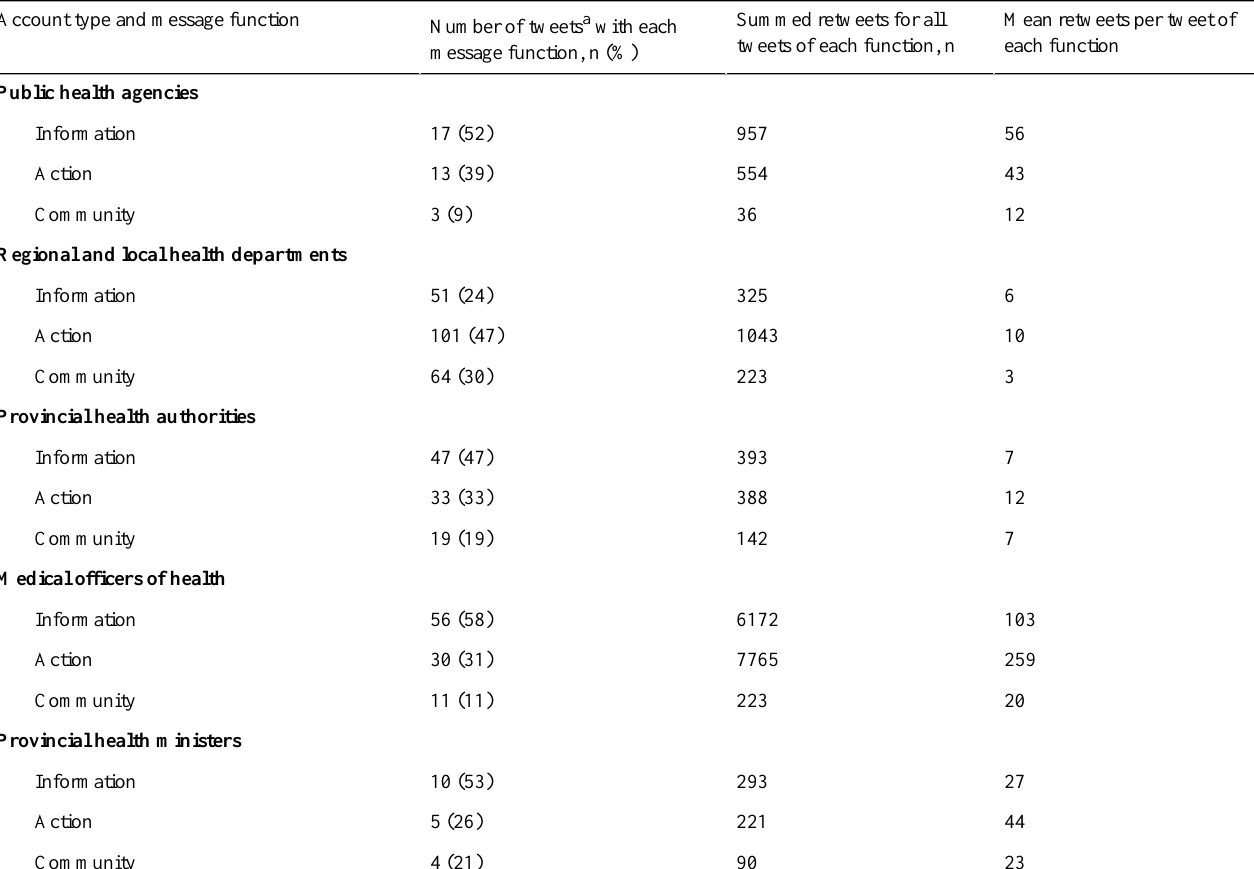
Table 3. Summed tweet (n=464) and retweet frequencies and percentages by message function and account type, January 1, 2020, to June 30, 2020.